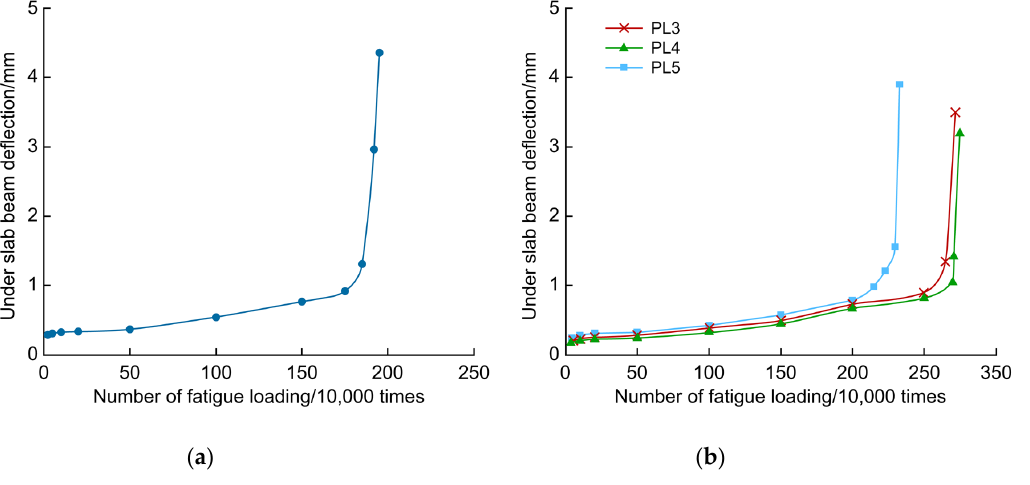
Figure 15. Relative curves between beam deflection and fatigue cycles under the slab at loading point ( a ) Unreinforced beam and ( b ) Reinforced beam.